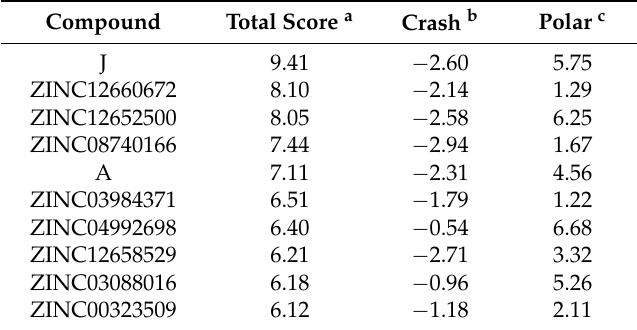
Figure 4. Structures of retrieved hits from the Zinc database with docking score values of more than 6. Table 2. Docking score values of the retrieved hits and known PDF inhibitors (A and J).